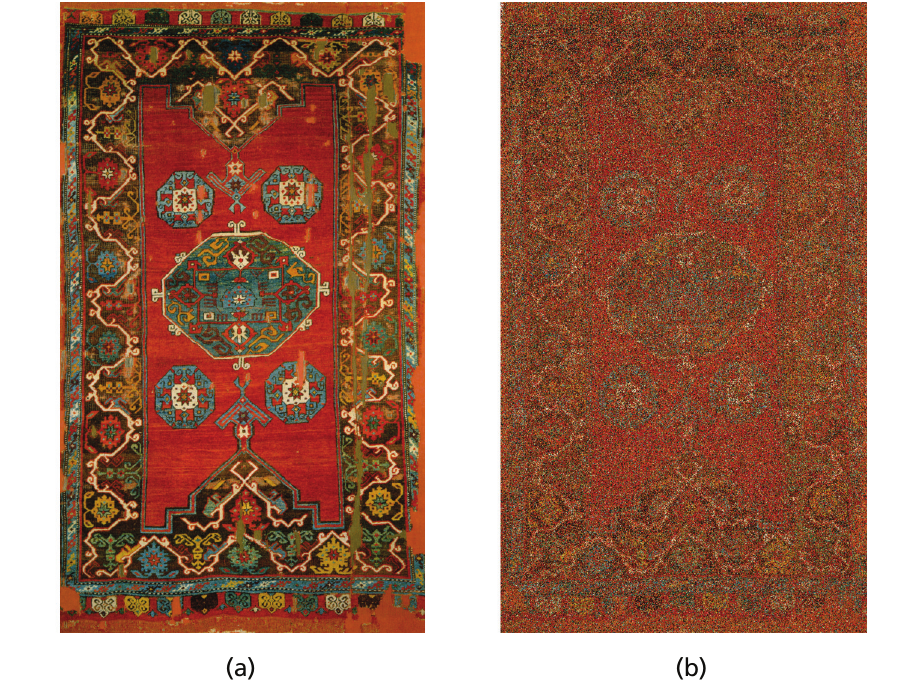
Figure 12. ( a ) Waving Border carpet; ( b ) Waving Border randomized. Source: { Foreshadowing } [22] for ( a ) and Author R.P.G. for ( b